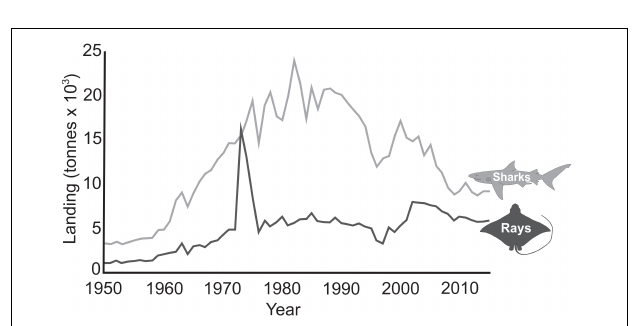
FIGURE 9 | Landing for sharks and rays in Brazilian marine waters